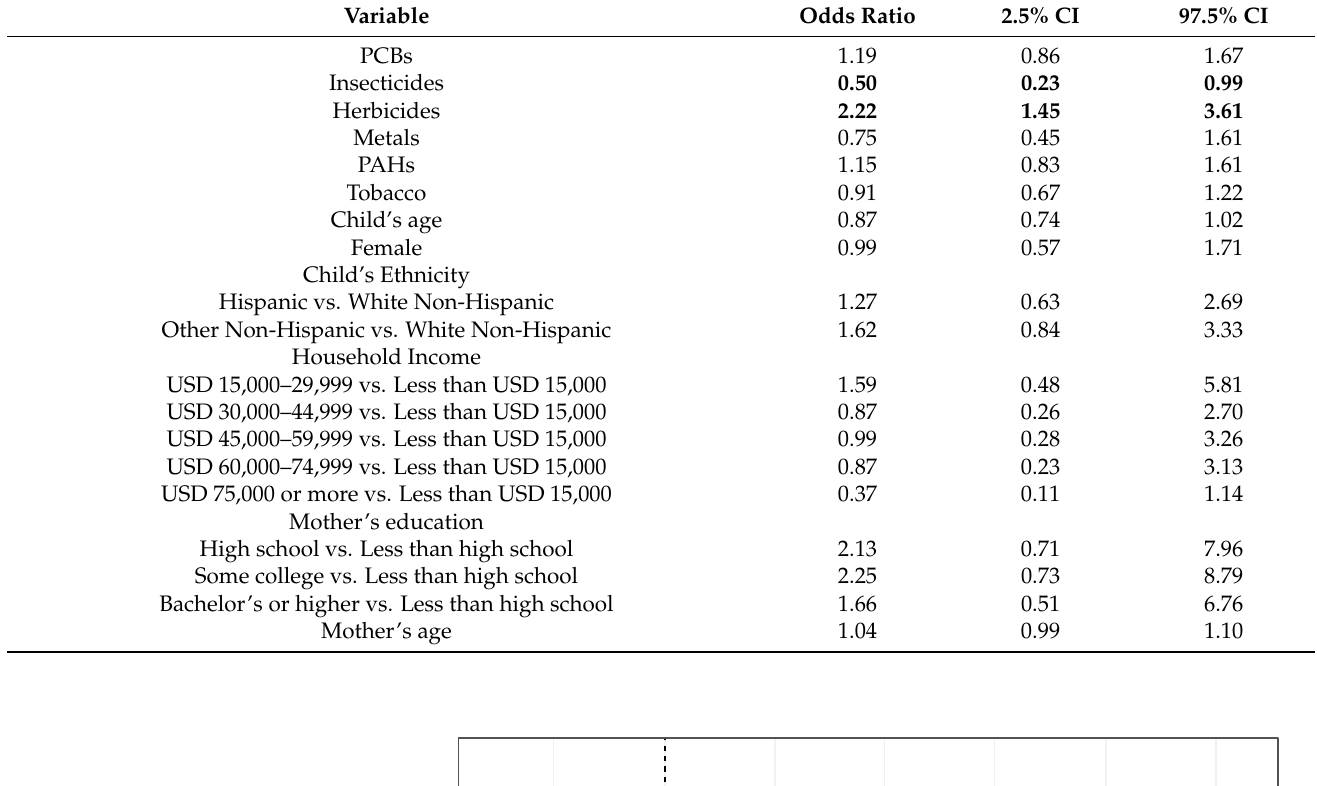
Table 7. Odds ratios and 95% credible intervals for chemical groups and demographic variables from the Bayesian group index model for subjects with same residence since birth. Bold indicates significant effects according to 95% credible intervals.